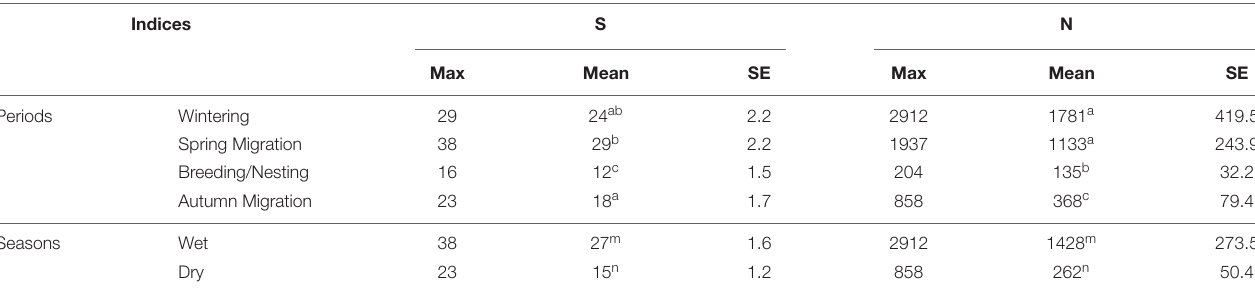
FIGURE 3 | Number of monthly recorded species in the GLw-Natura2000 based on counts during the period November 2016—January 2019. TABLE 3 | Estimated marginal means (Mean) and standard errors (SE) for waterbirds’ richness (S) and abundance (N) during the different seasons and periods, based on GLM analysis (GLM analysis for S was based on a Poisson distribution, and GLM analysis for N was based on a Negative Binomial distribution, using log as a link function in both